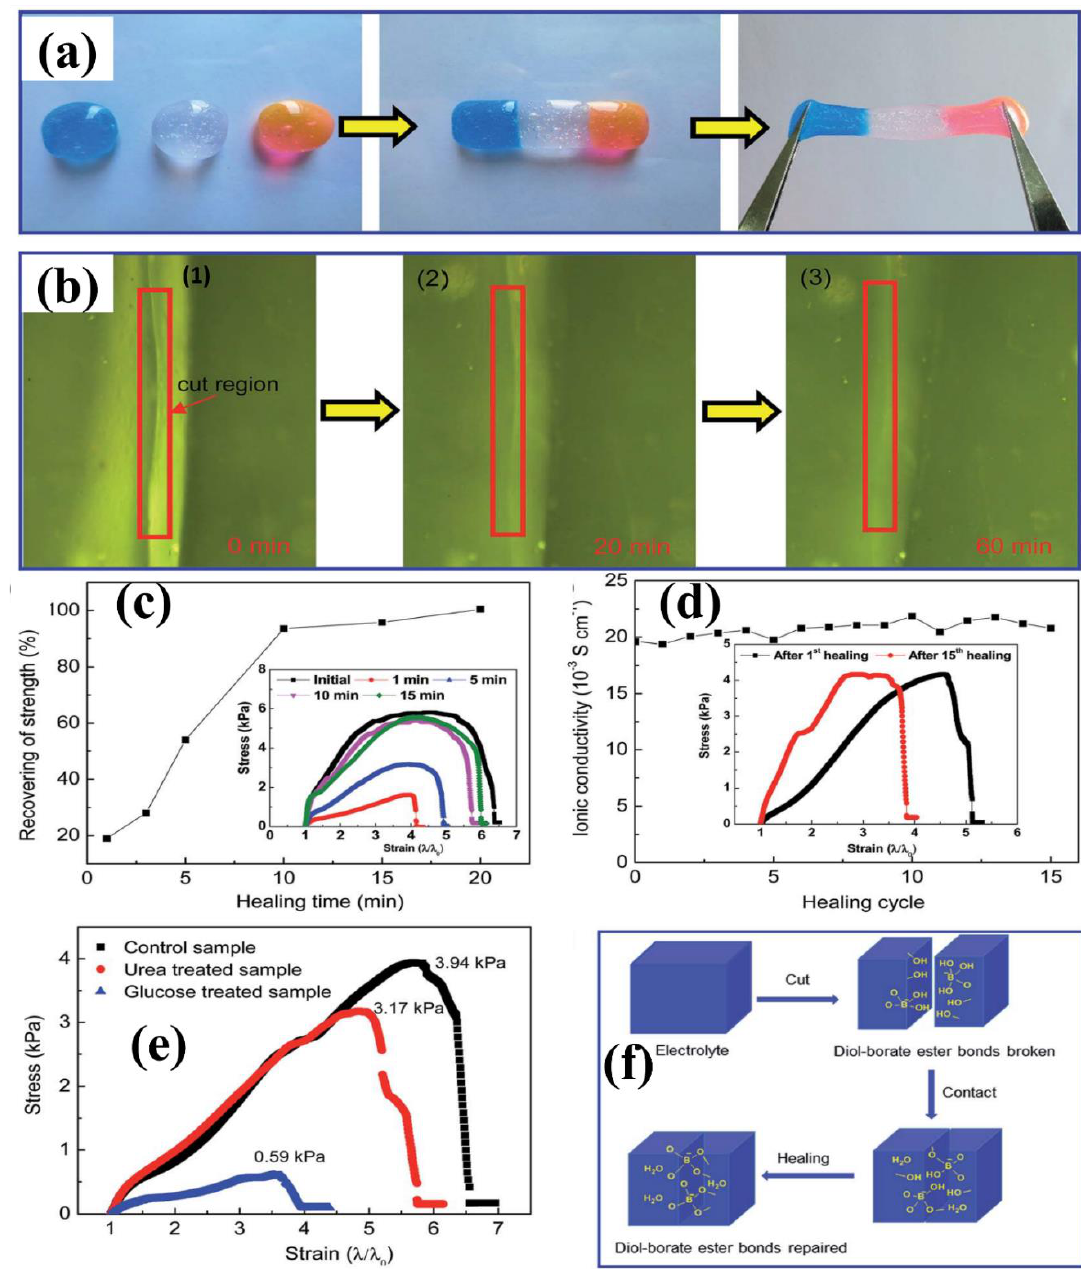
Figure 21. ( a ) Optical images showing self-healing of the PVA-g-PAA/KCl pieces under ambient conditions. ( b ) Fluorescence microscopy images of the electrolytes after healing for ( 1 ) 0 min, ( 2 ) 20 min, and ( 3 ) 60 min. ( c ) Effect of healing time on the mechanical properties and mechanical healing efficiency of the PVA-g-PAA/KCl electrolytes; the grafting amounts of PAA and KCl contents were 3.5 wt.% and 200 mM, respectively. ( d ) Ionic conductivity of the electrolytes after different cutting/healing cycles; the inset shows the mechanical properties after the 1st and 15th cutting/healing cycles. ( e ) Effect of urea and glucose treatments on the mechanical properties of the healed electrolytes. ( f ) Schematic illustration of the self-healing mechanism [195] .